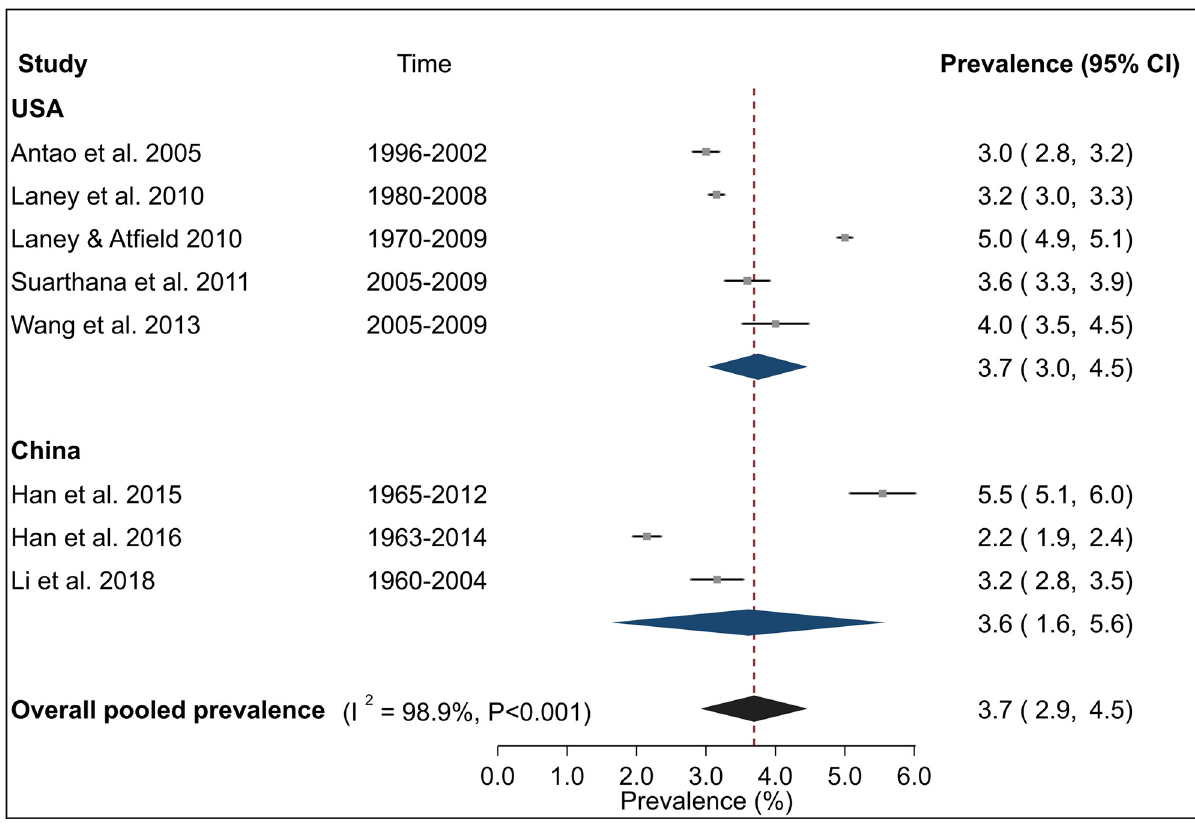
Fig 2. Forest plot from meta-analysis for overall prevalence of coal worker’s pneumoconiosis (CWP) among underground coal miners. Abbreviations are USA United States. The red dashed line corresponds to the overall effect size to guide the eye.